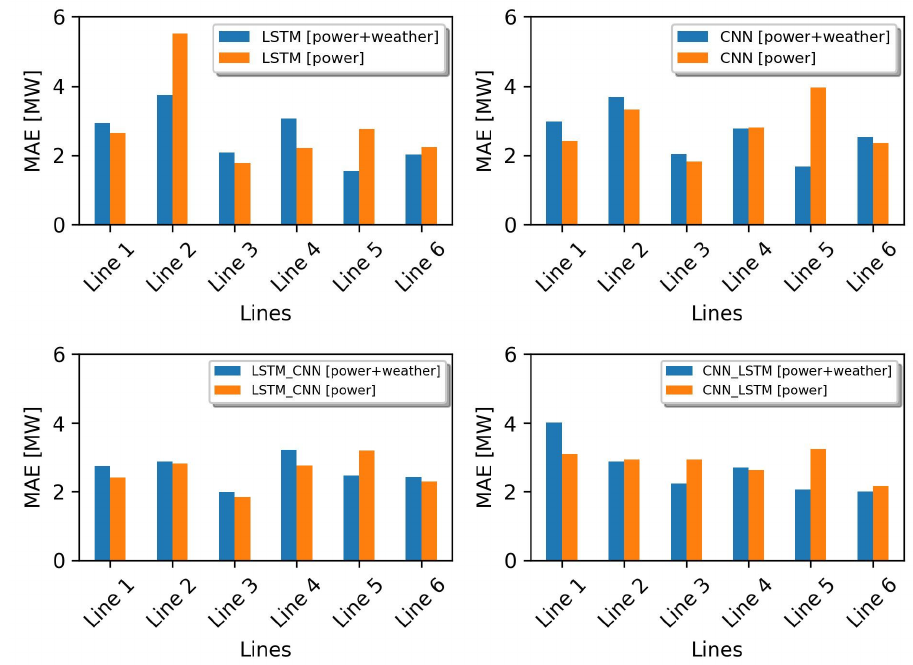
Figure 12. Performance comparison based on the MAE metric.